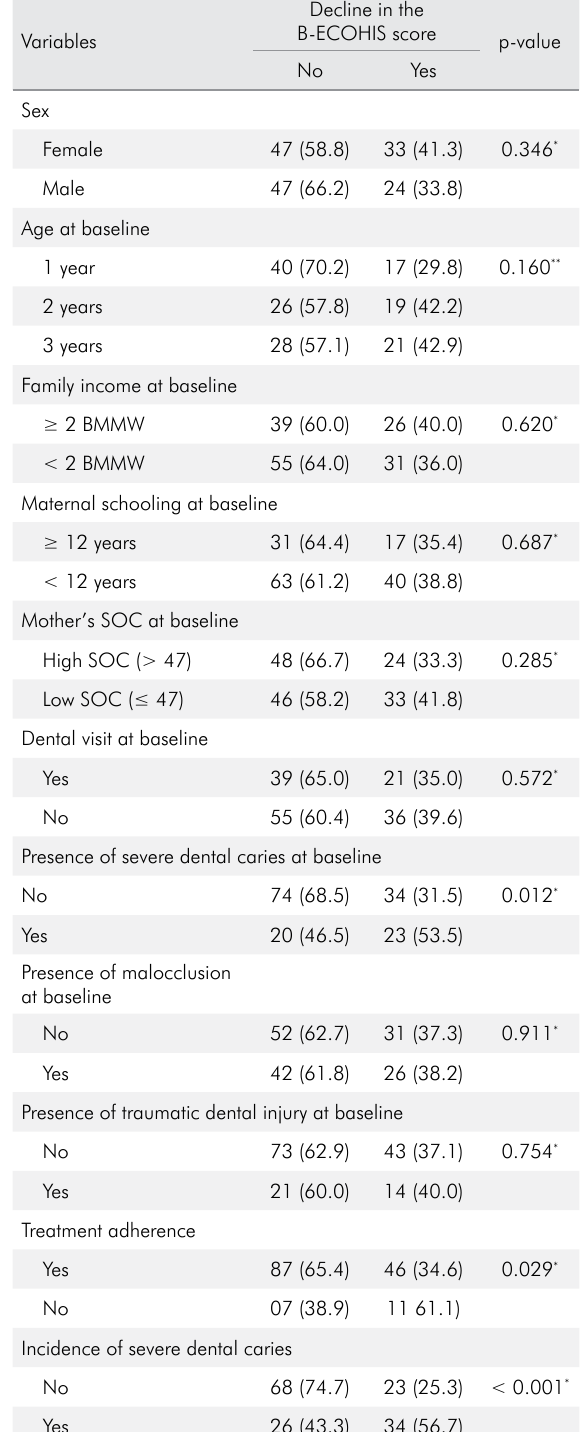
Table 2. Analyses of associations between characteristics of children and demographic/socioeconomic and clinical variables according to the decline in the B-ECOHIS score (n =